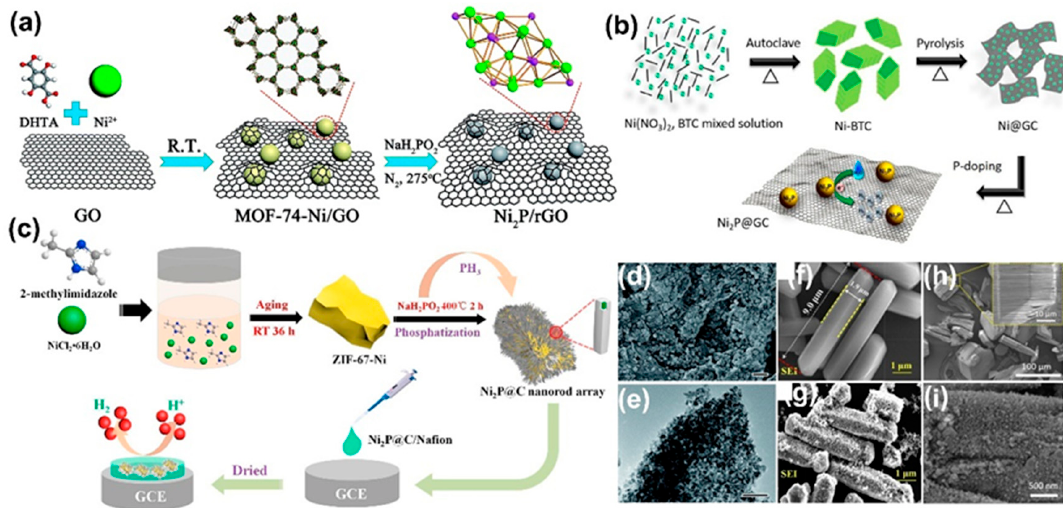
Figure 7. Schematic illustration of the synthesis procedure for the Ni 2 P / rGO ( a ), high magnification SEM ( d ), and TEM ( e ) images of the Ni 2 P / rGO. Reproduced with permission from Reference [106],